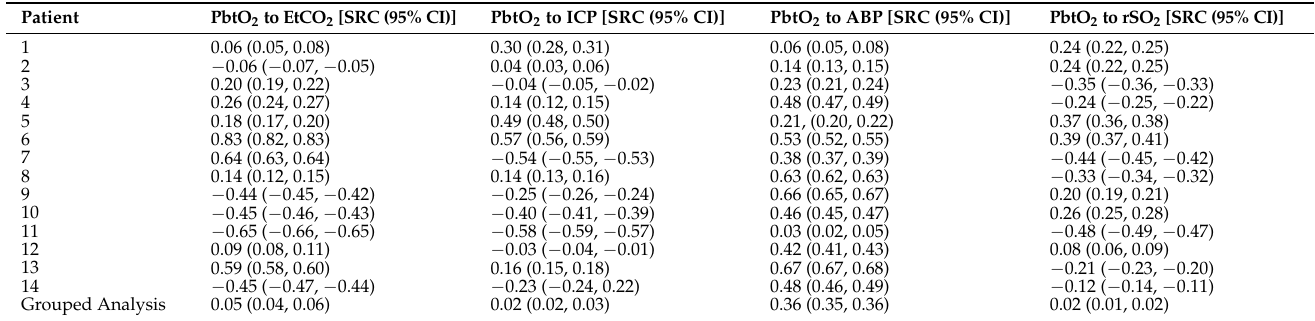
Table 3. Physiologic Relationships of PbtO 2 to ICP, ABP and rSO 2 .